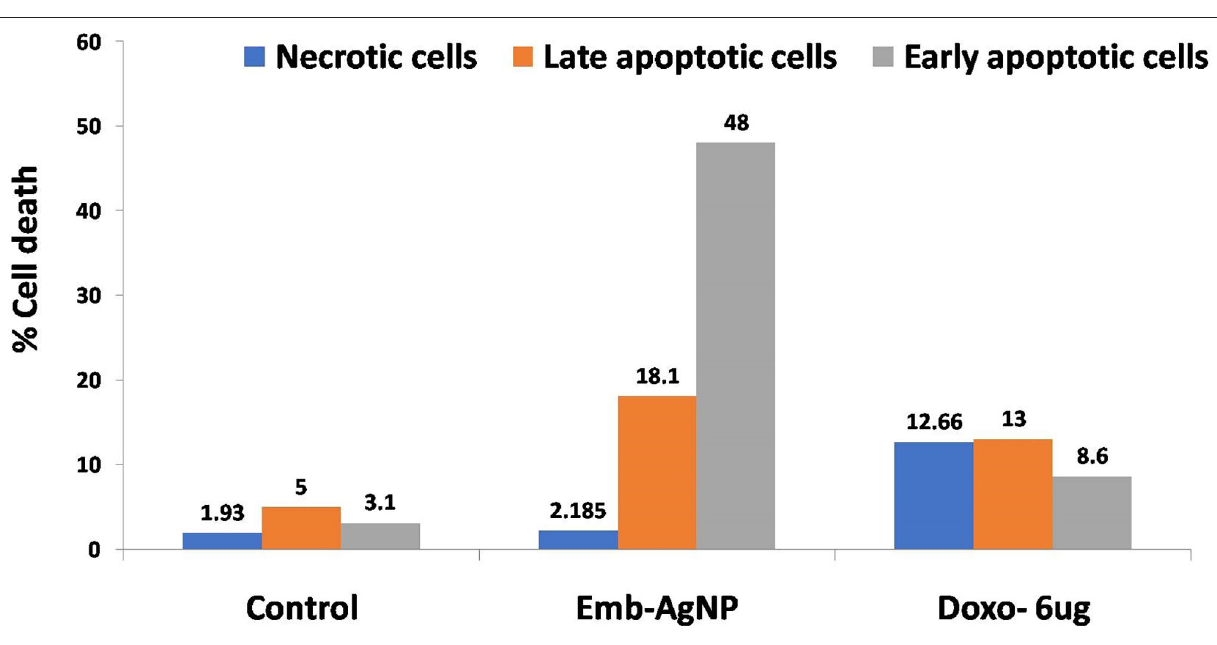
FIGURE 6 | Annexin PI assay for apoptosis analysis. Emb, embelin; Doxo,